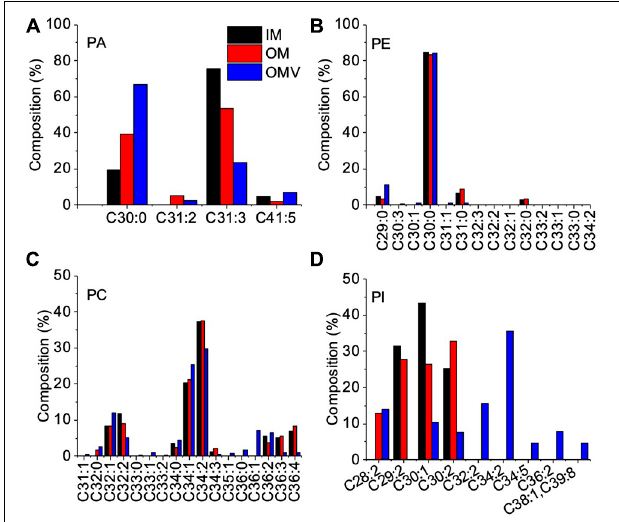
FIGURE 2 | Fatty Acid Composition of Phospholipids in the IM, OM, and OMVs of C. ochracea. Percentage composition of fatty acids in phospholipids of (A) PA, (B) PE, (C) PC, and (D) PI. Fatty acids were identified by comparing their retention times with standards. Nonacosanoic acid (C29:0), Triacontanoic acid (C30:0), Hentriacontanoic acid (C31:0), Dotriacontanoic acid (C32:0), Tritriacontanoic acid (C33:0), Tetratriacontanoic acid (C34:0), Hexatriacontanoic acid (C36:0).